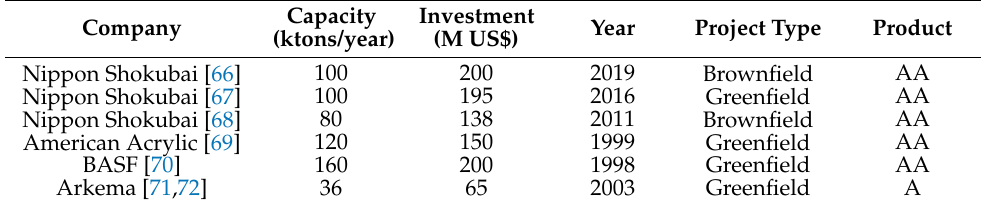
Table 2. Historical data for acrylic acid and acrolein plants.